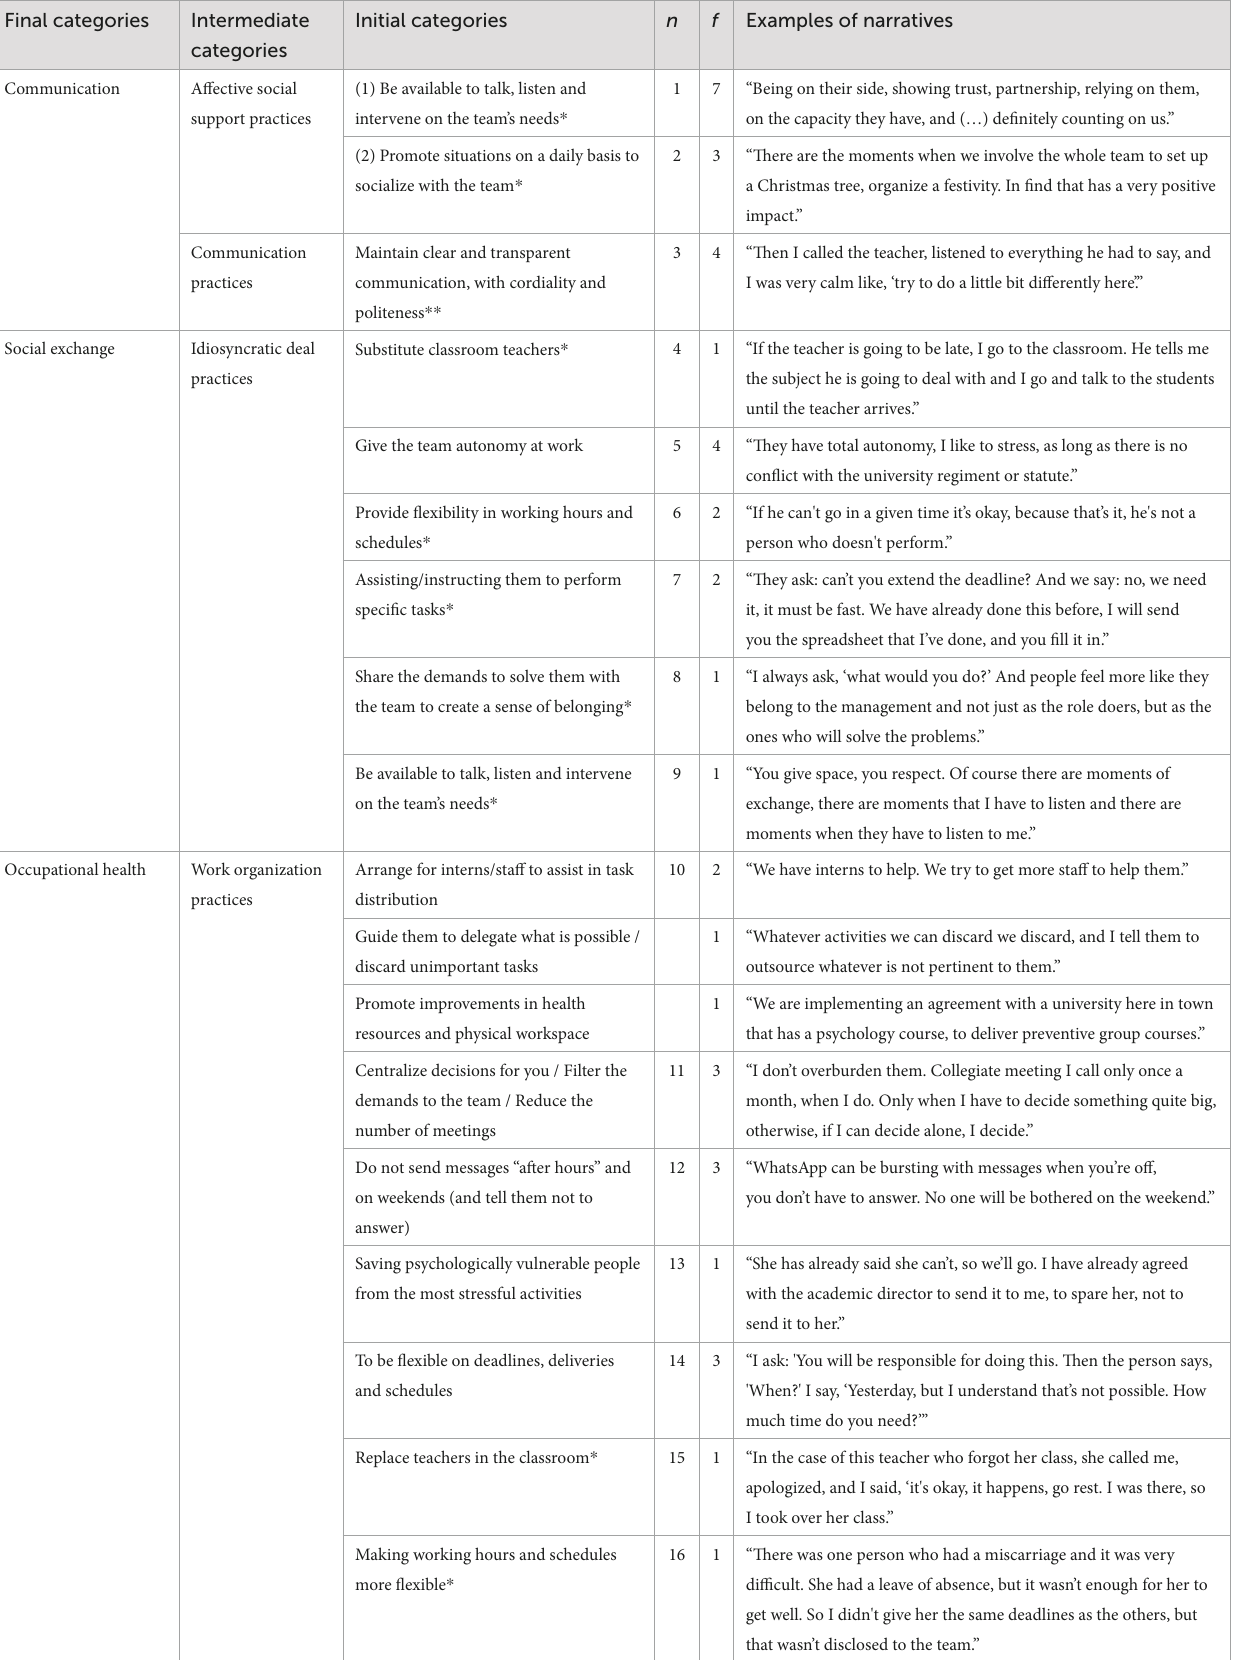
TABLE 1 Human resource management practices adopted according to the managers’ perception. Human resource management practices adopted according to the managers’